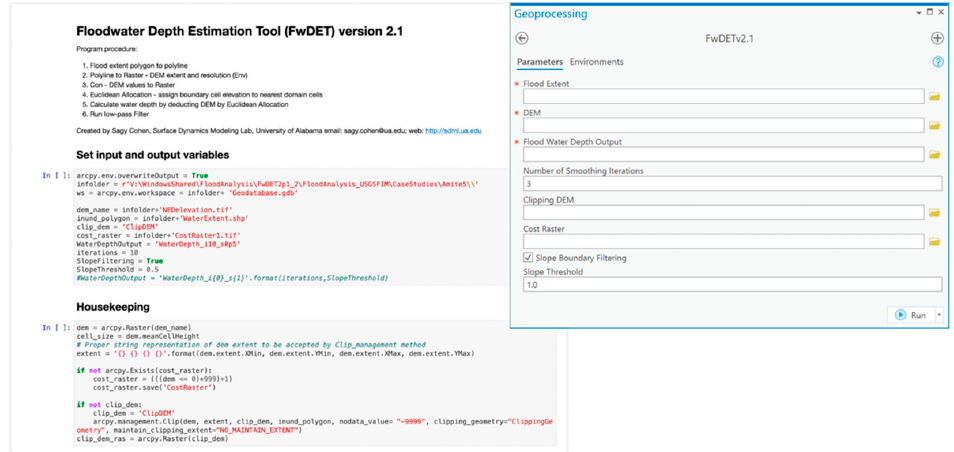
Figure 12. Screenshots of FwDET2.1 ArcGIS Pro interfaces: ( left ) top section of the Jupiter Notebook, and ( right ) Geoprocessing Script Tool user interface.